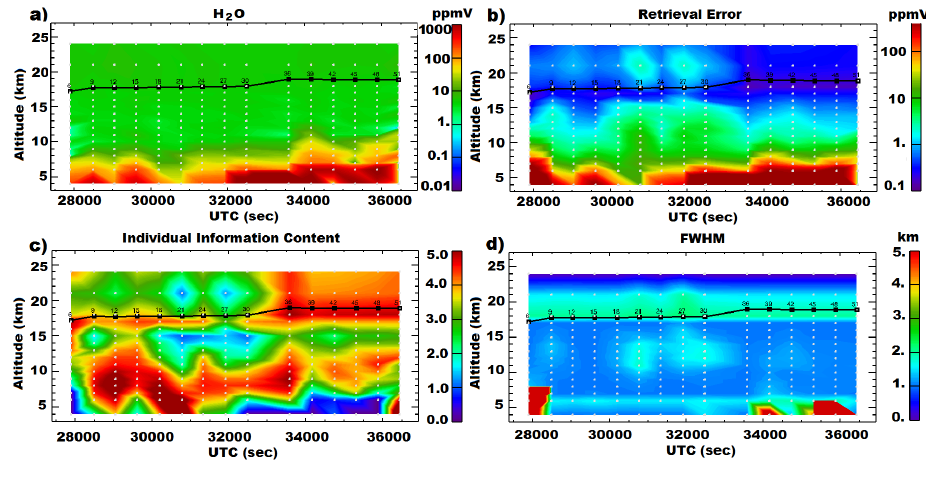
Fig. 6. As in Fig. 5 but for H 2 O retrieved from band C scans only.